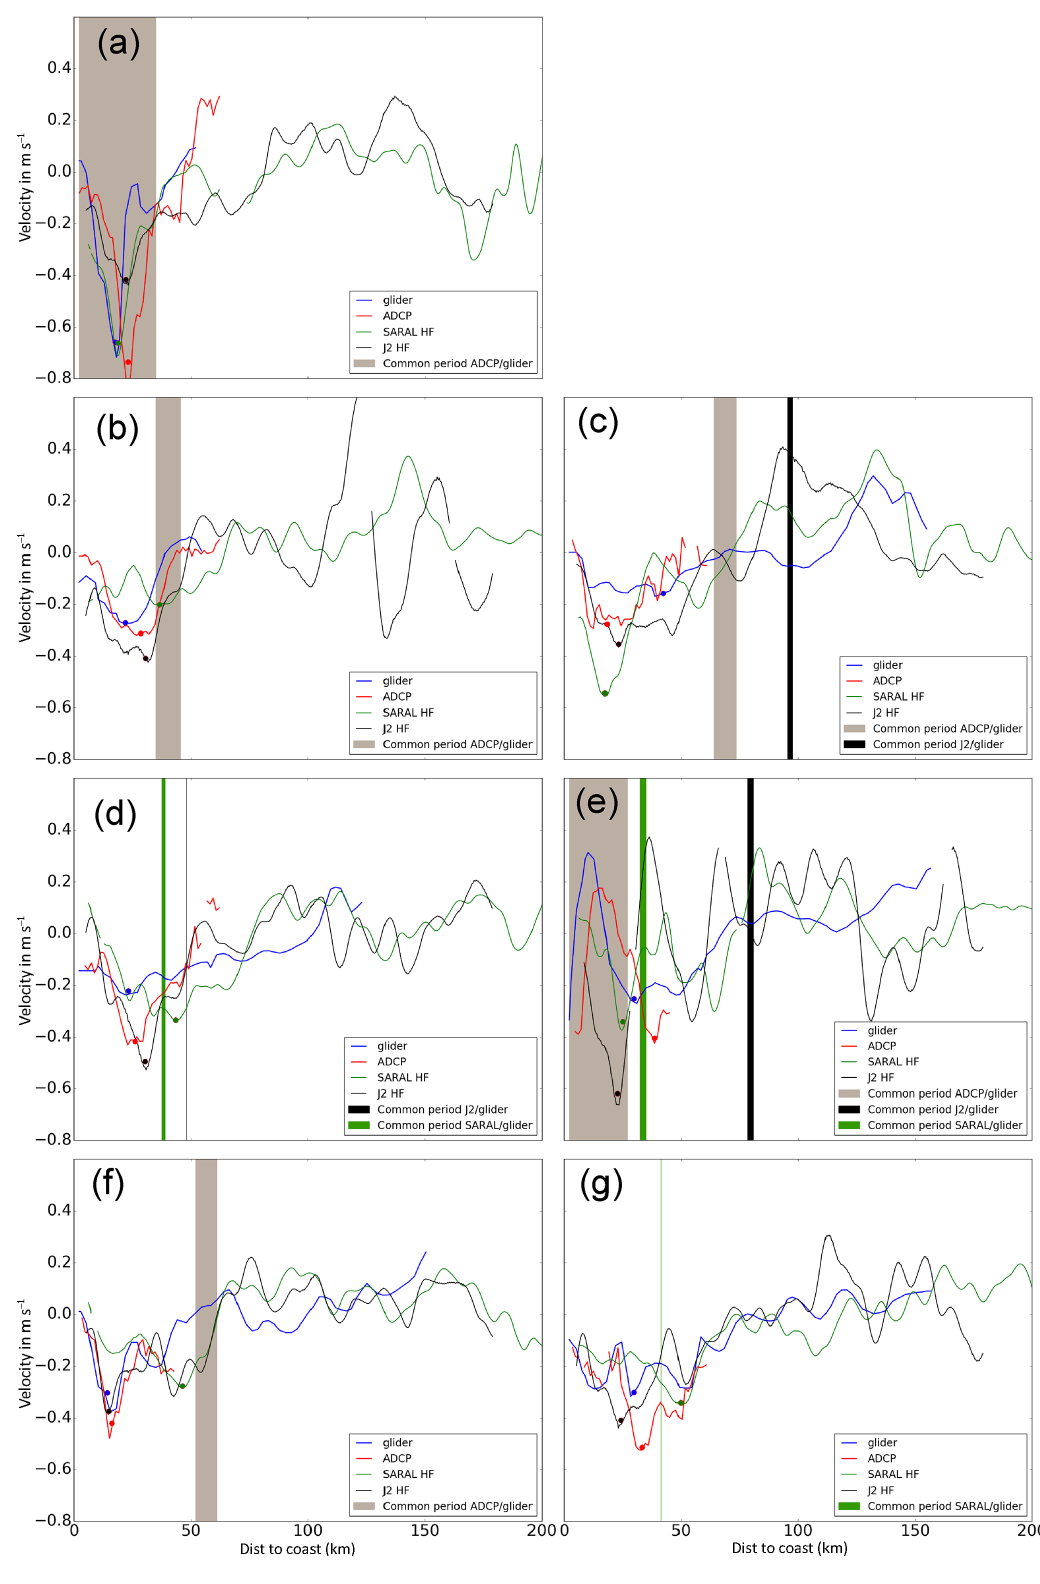
Figure 7. Same as Fig. 6 but for HF altimetry